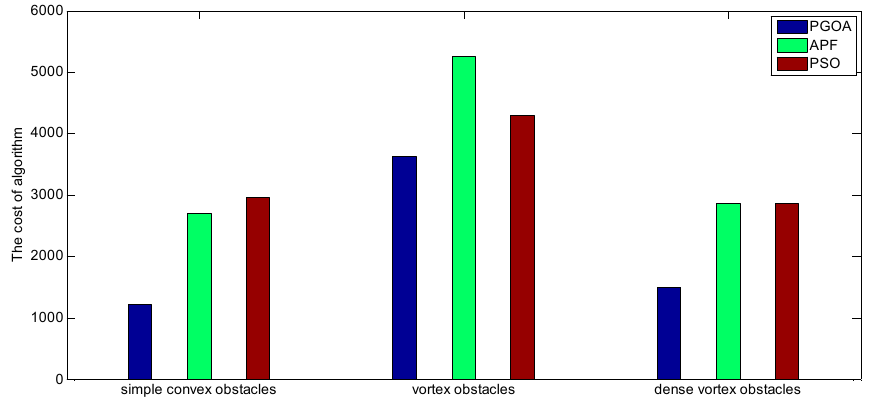
Figure 16. Algorithmic cost in three obstacle environments.